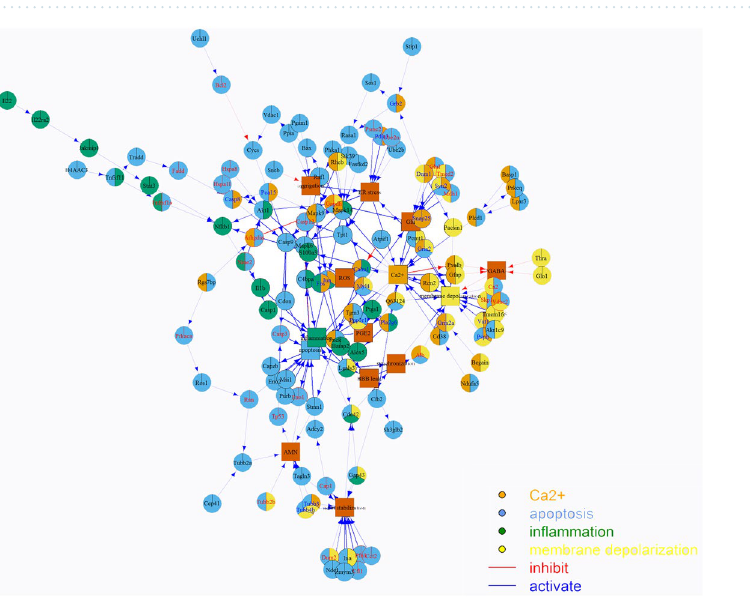
Figure 2. The process of detection and recognition of different spots. Differently expressed spots in each epilepsy model rather than control were visualized and recognized by MALDI–TOF–TOF/MS spectrometer method after trypsin digestion. Commonalities and differences of changed proteins categorized between three models as a Venn diagram. The short name of each identified protein for each group is indicated.